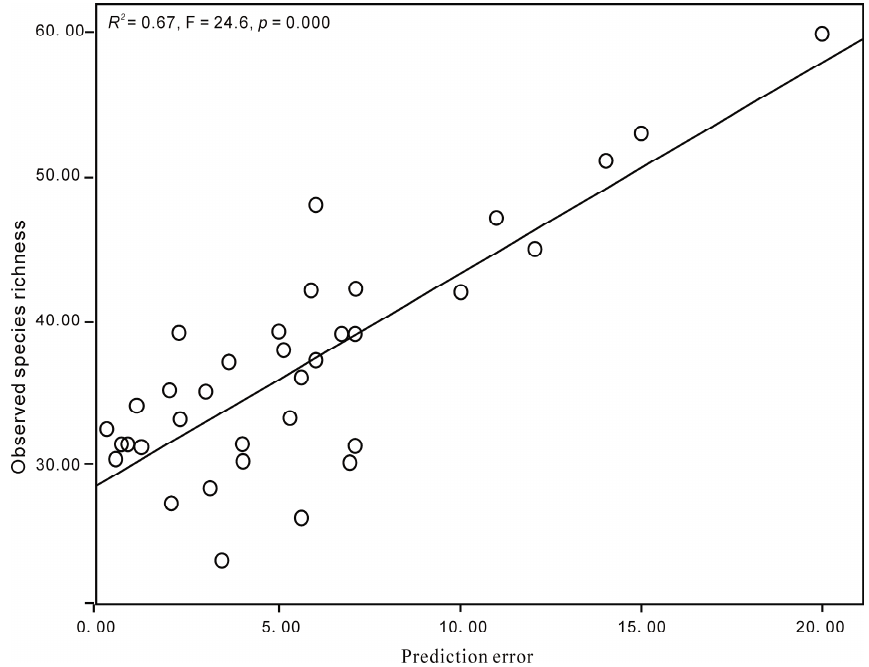
Figure 7. Relation between the observed species richness and the prediction error.